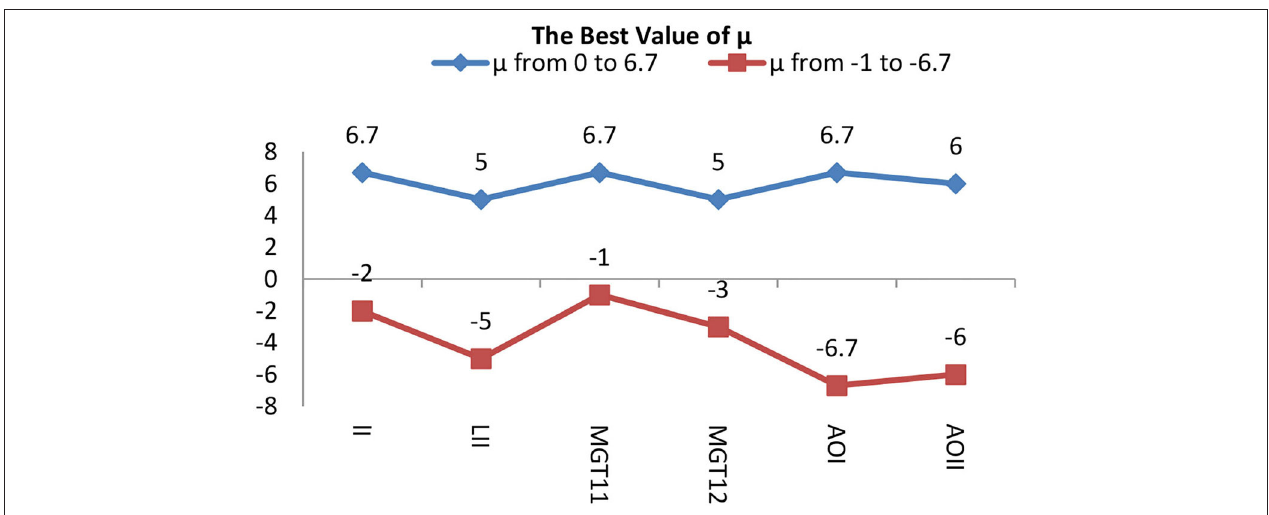
FIGURE 11 | The best values for the six images of group